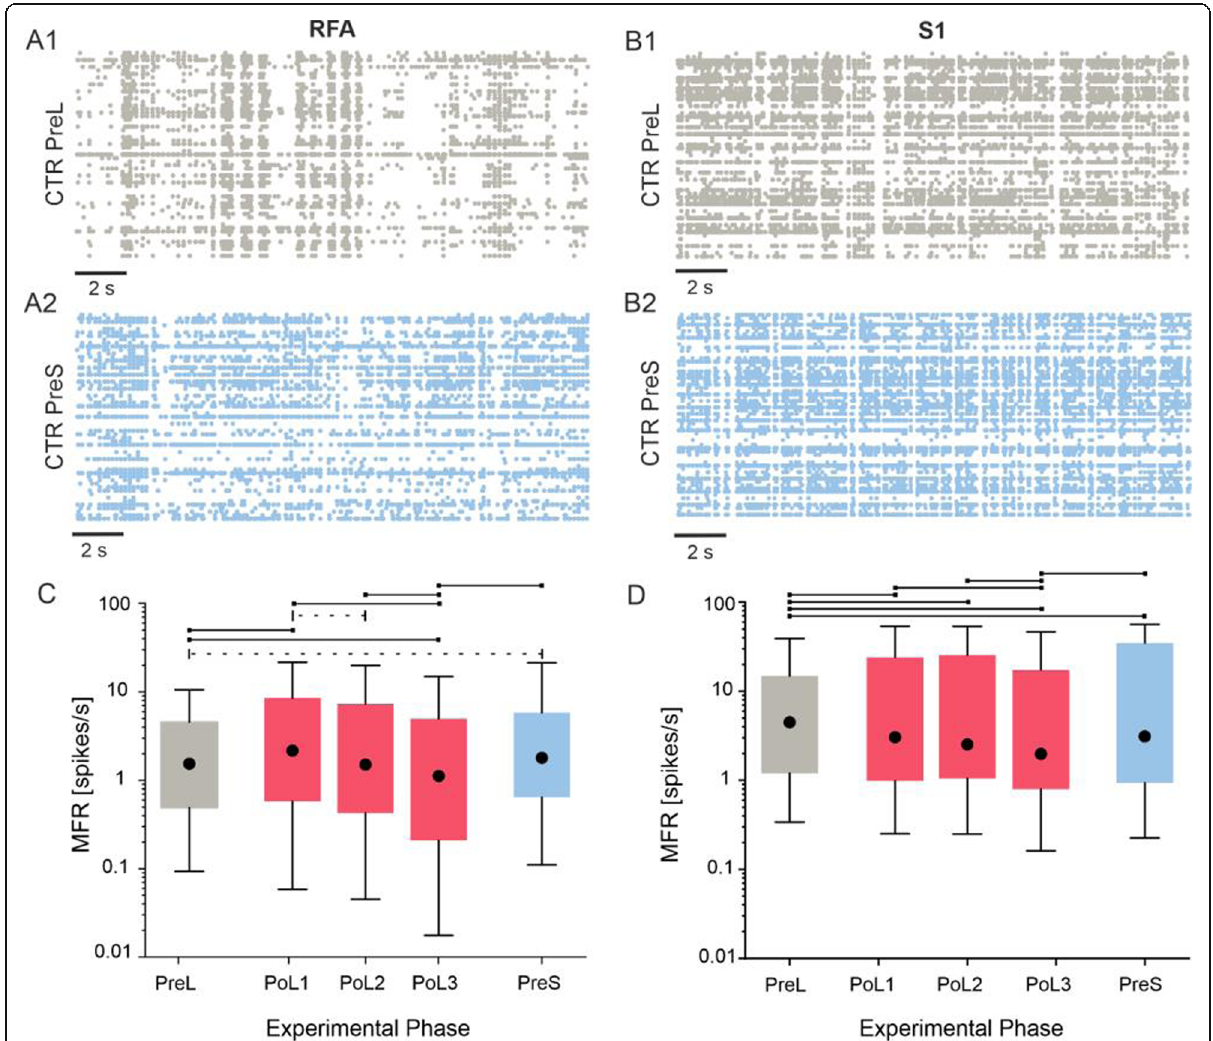
Fig. 2 Effect of the lesion on firing rate. A) 20-s raster plots of the activity recorded in RFA in a representative Control (CTR) experiment: Pre Lesion - PreL phase ( A1 ), Pre Stim phase - PreS ( A2 ). B) 20-s raster plots of the activity recorded in S1 in a representative Control (CTR) experiment: Pre Lesion - PreL phase ( B1 ), Pre Stim phase - PreS ( B2 ). Each single dot represents a spike; each line of the raster plot reports the activity of a single unit. C) Box plot of the Mean Firing Rate (MFR, spikes/s) of RFA for the entire dataset of CTR experiments. D) Box plot of the Mean Firing Rate (MFR, spikes/s) of S1 for the entire dataset of CTR experiments. For each box plot ( C-D ), the central black dot indicates the median, the box limits indicate the 25th and 75th percentiles. Whiskers represent the 5th and the 95th percentiles. Dashed line p < 5·10 − 2 ; solid line p < 5·10 − 5 Friedman non parametric test. Color code as in Fig.